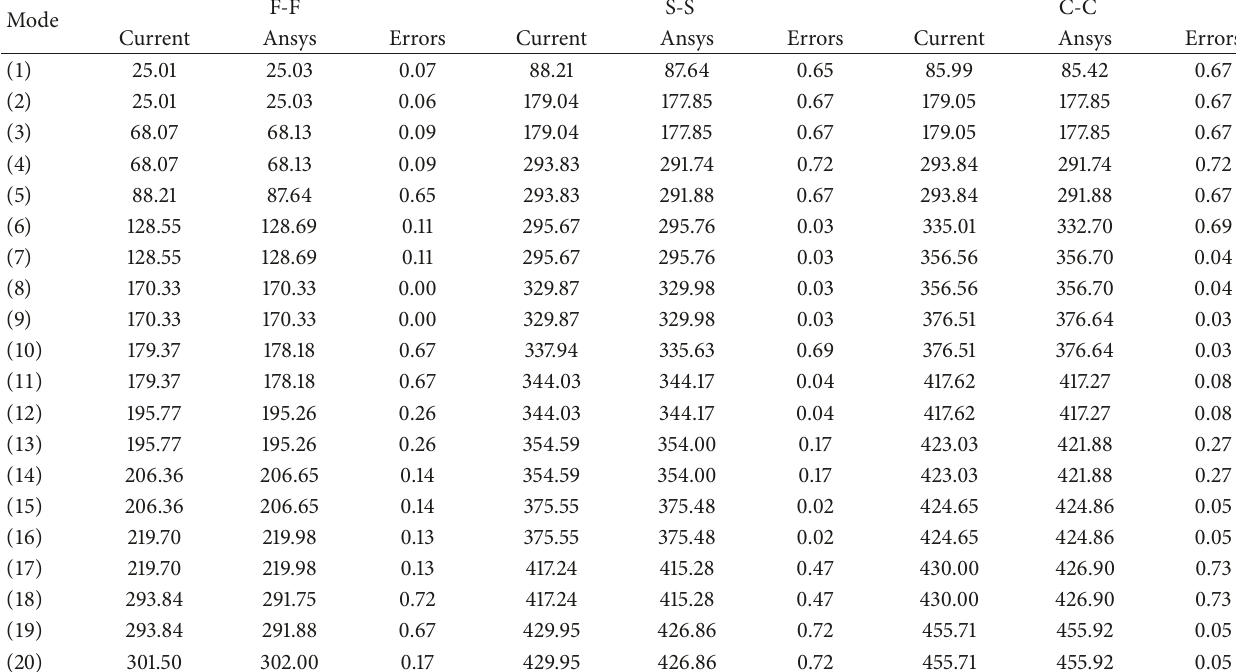
Table 1: The frequency for the coupled structure with symmetrical boundary condition 𝑓